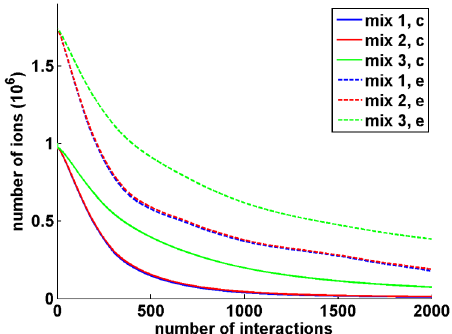
FIG. 9. Clearing times of ion clouds with different composi- tions (mixture 4 – 6) in a circular beam pipe. 5000 bunch- interactions correspond to a clearing time of about 4 μ